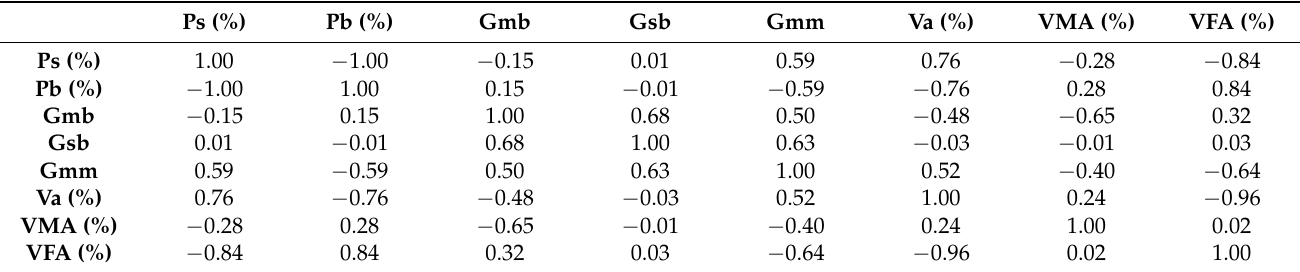
Table 1. Correlation of input parameters for